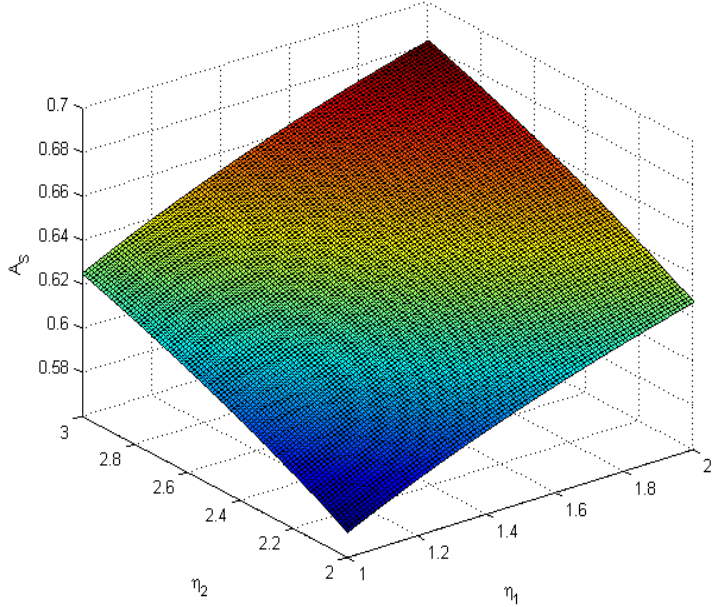
Figure 2. The steady-state availability of the server ( A S ) for λ = 1, µ = 2, ξ 1 = 1 and ξ 2 =